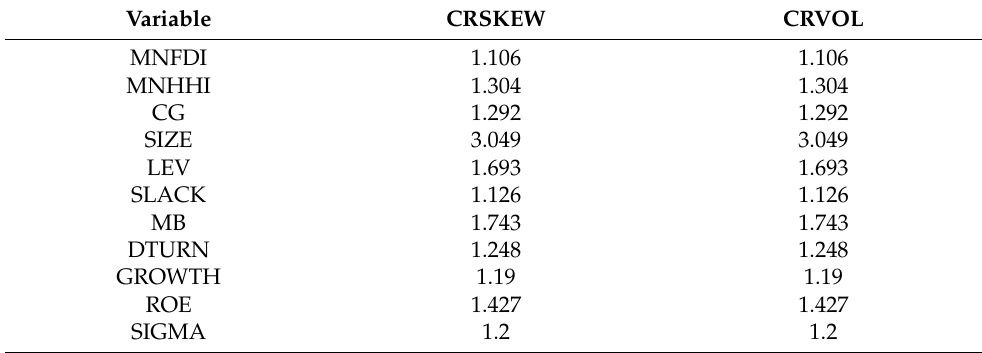
Table 4. Variance Inflation Factor for Independent